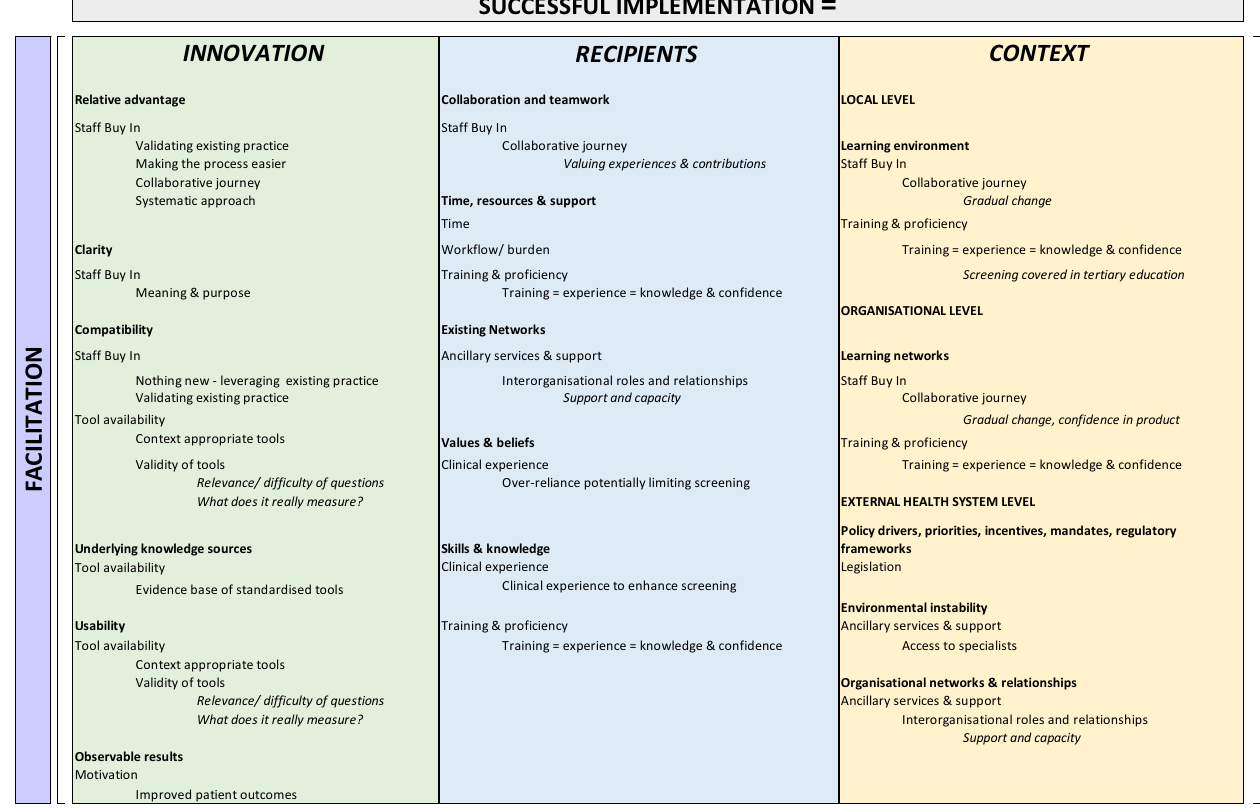
Figure 1. Themes and sub-themes contextualised within i-PARIHS domains.